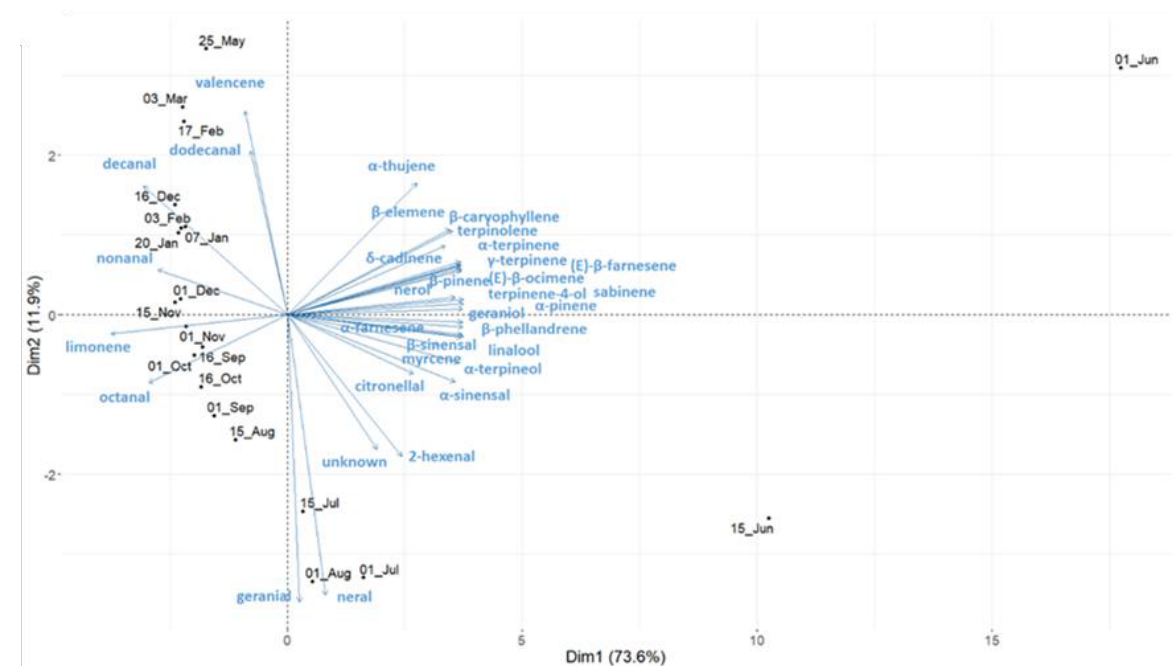
Figure 4. Biplots of principal component analysis representing the diversity of the PEO composition of each sampling date (in black) and the contribution of the 33 main aromatic compounds (in blue). Each sampling date represents the average composition of each compound of the five repetitions of “Cara Cara Navel” sweet orange.